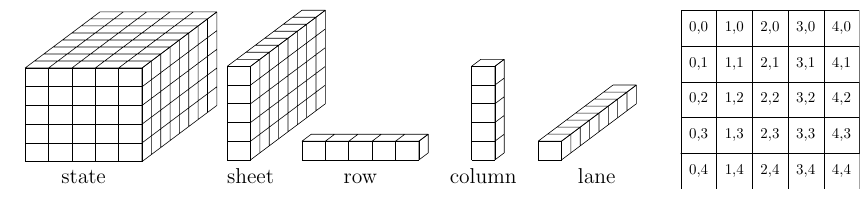
Figure 1: Notations of Keccak -